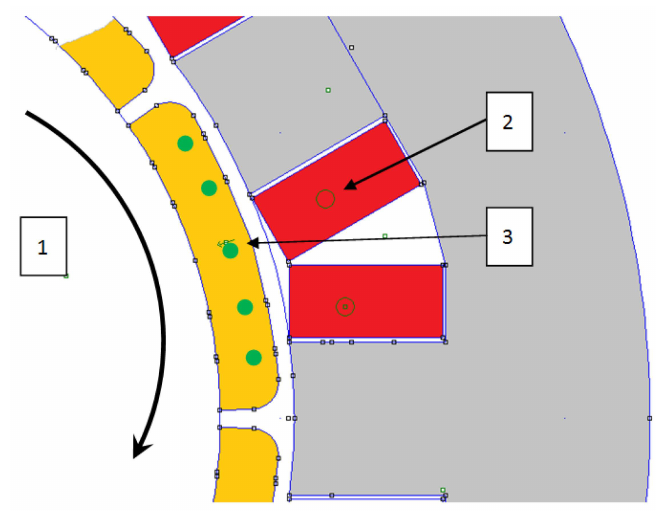
Figure 27. The position of the rotor is incremented step by step ( 1 ). At each step, the currents which correspond to this angular situation and the imposed load are set in the coils ( 2 ). At five points ( 3 ), the magnetic induction is calculated and these values are plot as a function of the rotor position (Figure 28a).